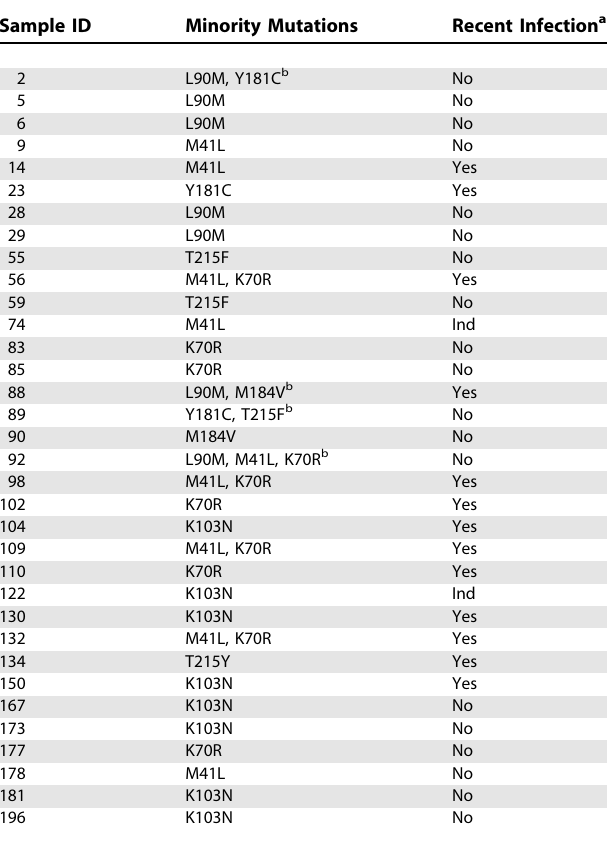
Table 3. Minority Drug Resistance Mutations Detected in the Wild-Type Group Cross-Sectional HIV-1 Samples Collected in